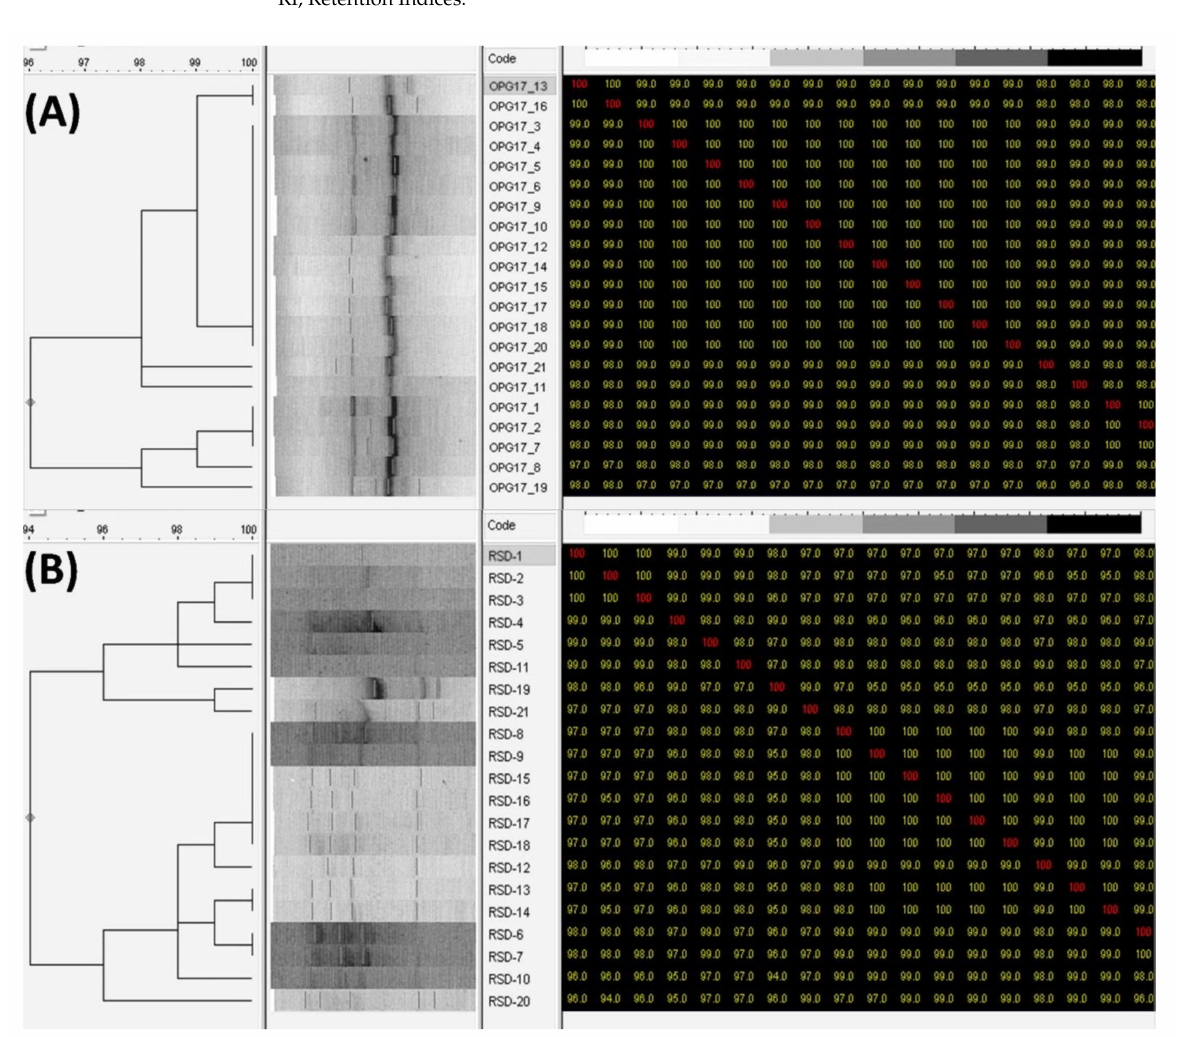
Figure 4. Dendrogram based RAPD-PCR data for C. albicans isolates from vaginal (1–10) and blood (11–20) in addition to identified isolate C. albicans 102311: ( A ) primer OPG-17, ( B ) primer